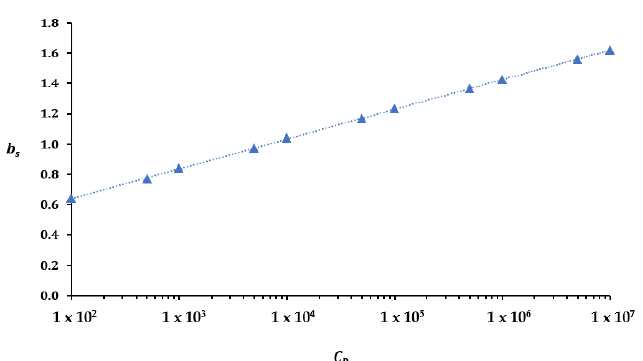
Figure 8. Graph of b si coefficients vs. log C D .